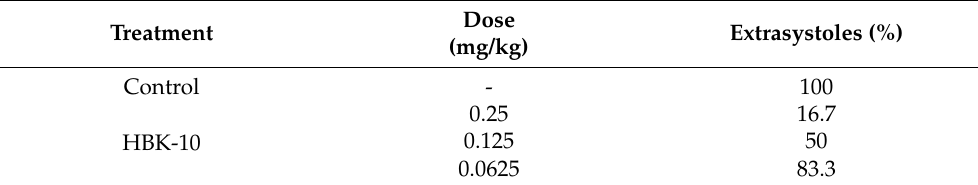
Table 2. The effect of HBK-10 on extrasystole occurrence in the adrenaline-induced arrhythmia model in